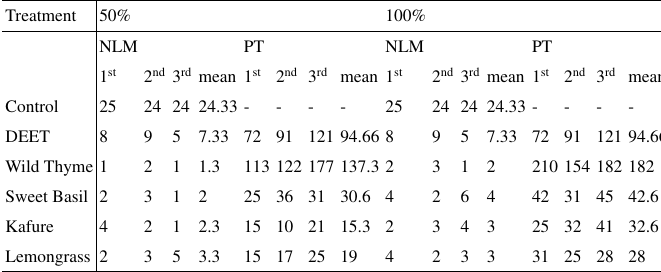
Table 2. Spatial repellent activity of 50% and 100% evaluated plants leaves ethanol extract against Anopheles mosquito based on the number of landed mosquitoes (NLM) and protection time per minute (PT).